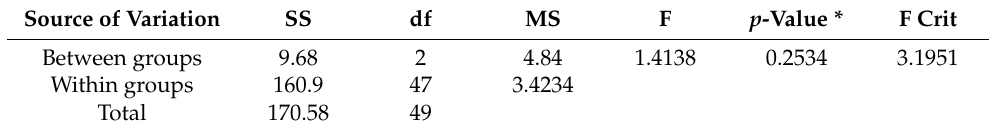
Table 3. Source of variation ANOVA. Source of